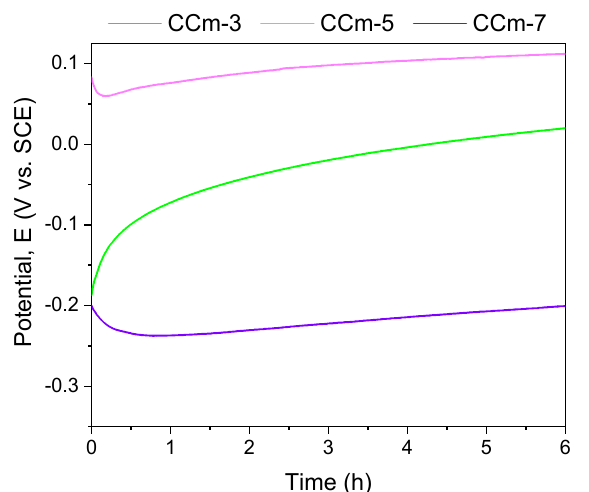
Figure 8. Open circuit potential evolution corresponding to the milled CoCr alloy in all testing me- dia.